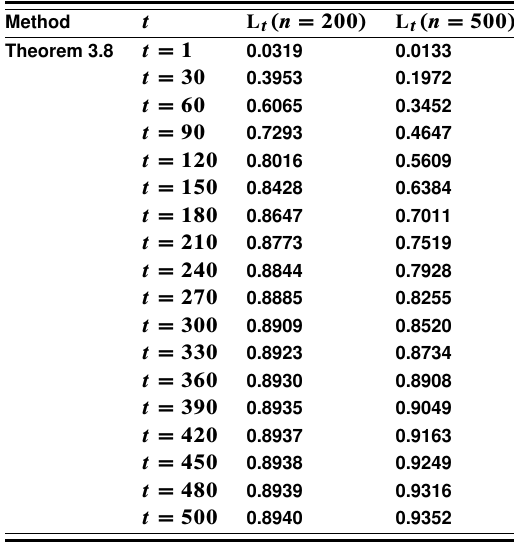
Table 2. The lower upper of (cid:28).A ı A (cid:0) 1